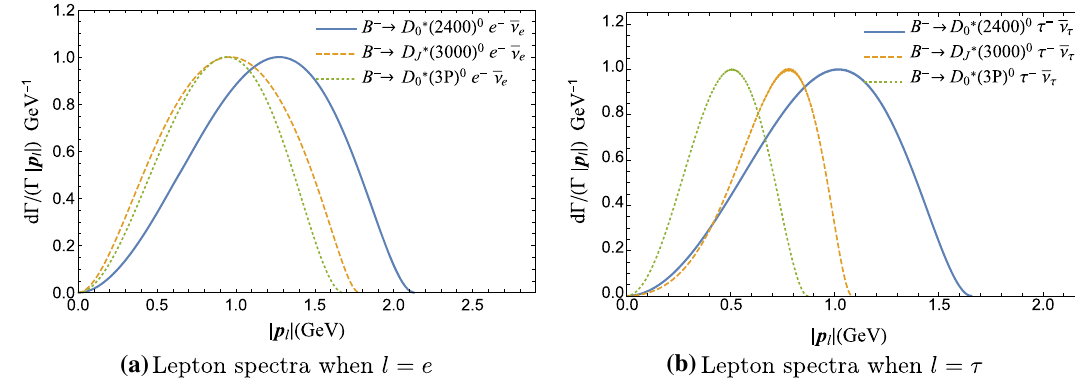
Fig. 6 The spectra of differential decay width vs | p l | (with normalization)